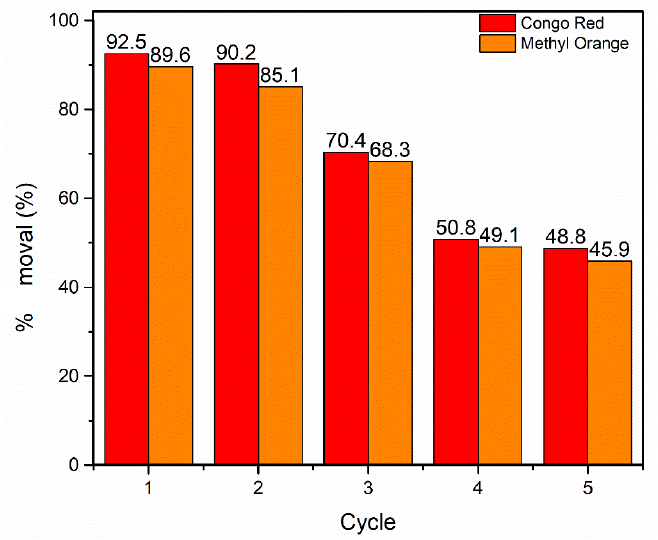
Figure 11. Reusability of the OCMC/BFO composite catalyst-loaded film for CR and MO dye photodegradation under direct sunlight irradiation.